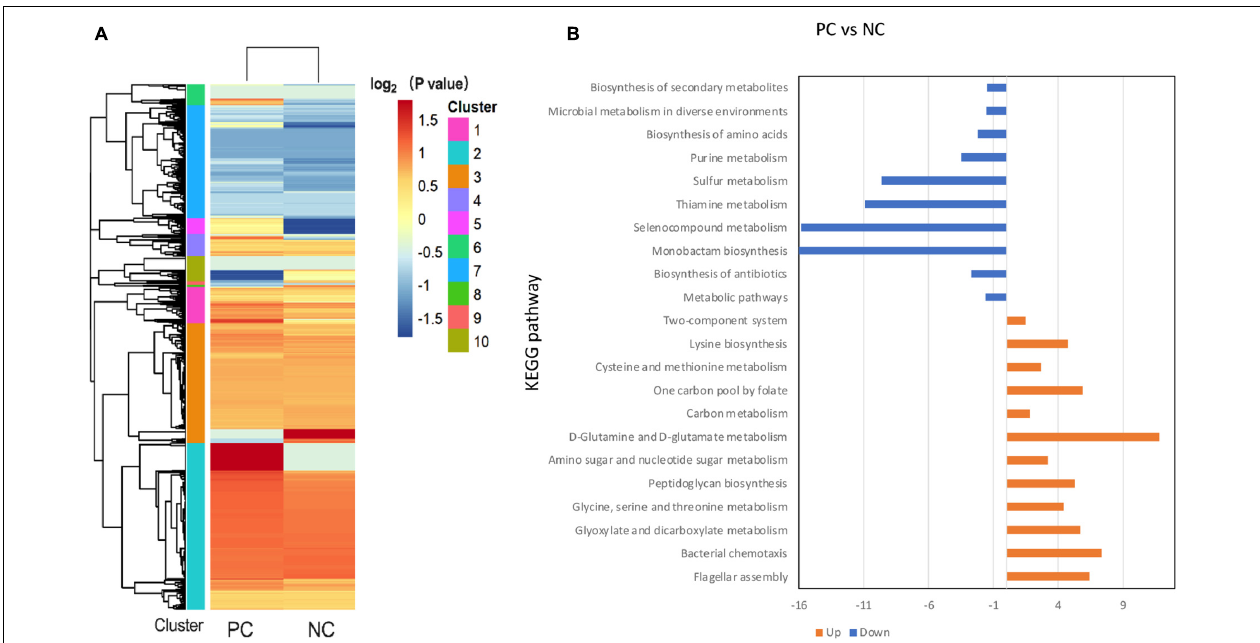
FIGURE 8 | Categorical proteomics summary of B. subtilis BS-15 in co-culture. (A) Heatmap of different identified proteins. (B) Identified proteins were mapped to different KEGG pathways. PC means positive bacteriocin-inducing co-culture of L. plantarum RX-8 and B. subtilis BS-15 (10 6 :10 6 CFU/ml) at 37 ◦ C for 20 h, and NC means negative bacteriocin-inducing co-culture of L. plantarum RX-8 and B. subtilis BS-15 (10 6 :10 4 CFU/ml) at 37 ◦ C for 20